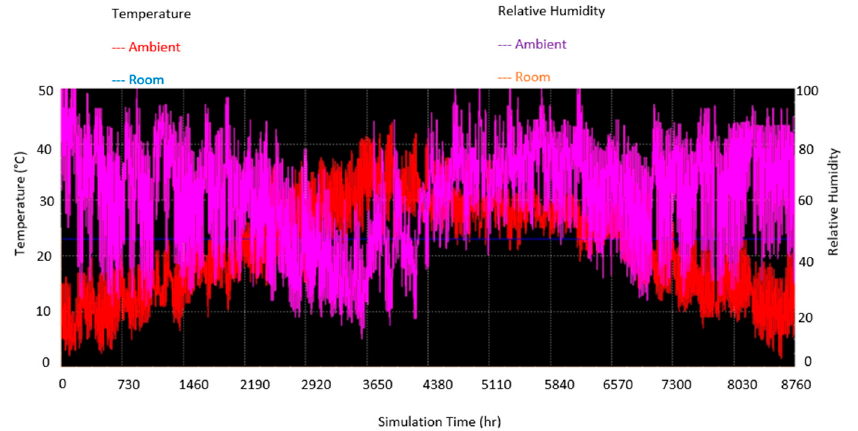
Figure 24. One year simulation run for option C.